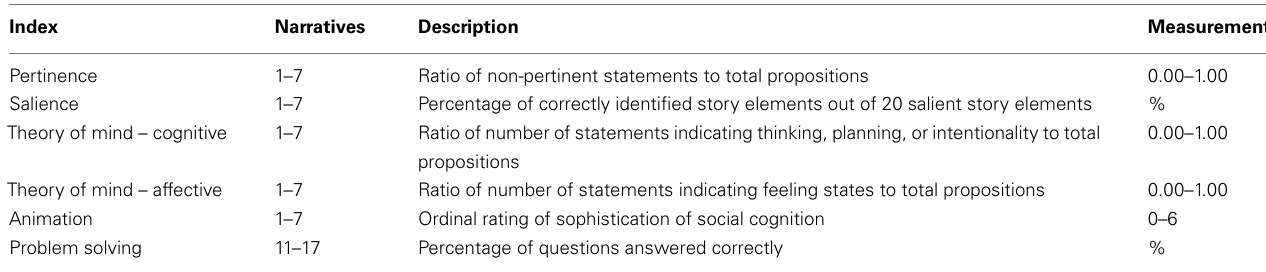
Table 1 | Overview of coding procedures.